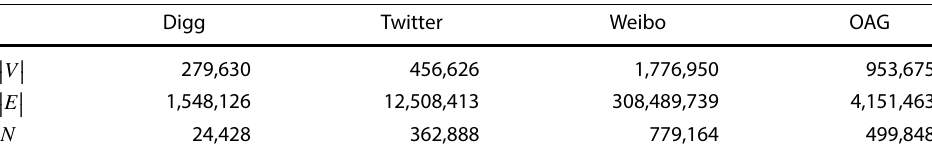
Table 1 The statistics of four datasets